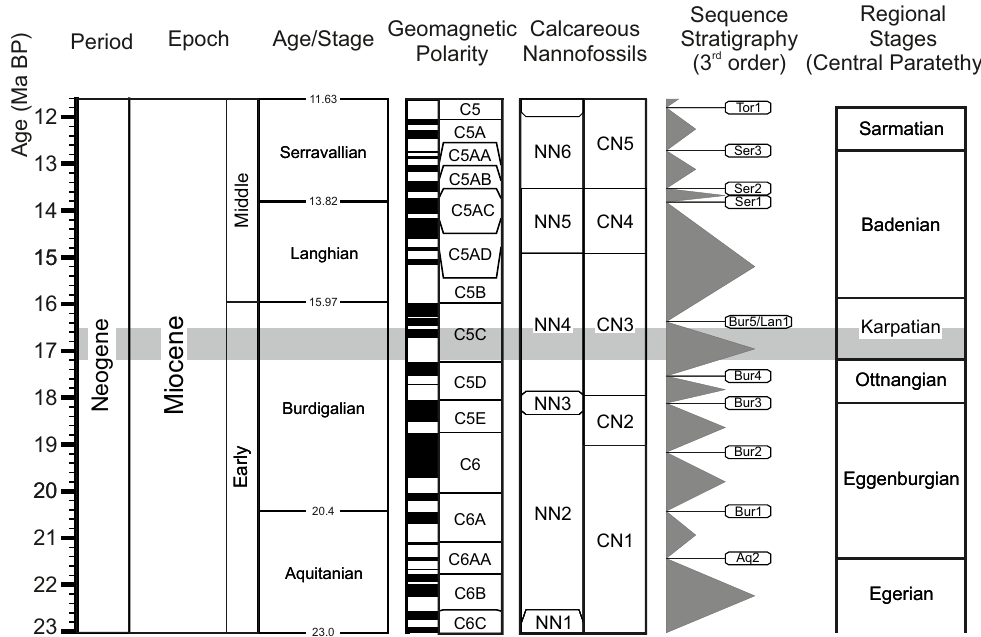
Figure 2. Stratigraphic table of the Early to Middle Miocene, showing global geochronology after Gradstein et al. (2012) and references therein. Regional stages of the Central Paratethys after Piller et al. (2007), with updated ages for the Ottnangian and Karpatian after Grunert et al. (2010b) and Dellmour and Harzhauser (2012). The grey bar indicates the stratigraphic position of the Laa Formation (after Auer et al.,